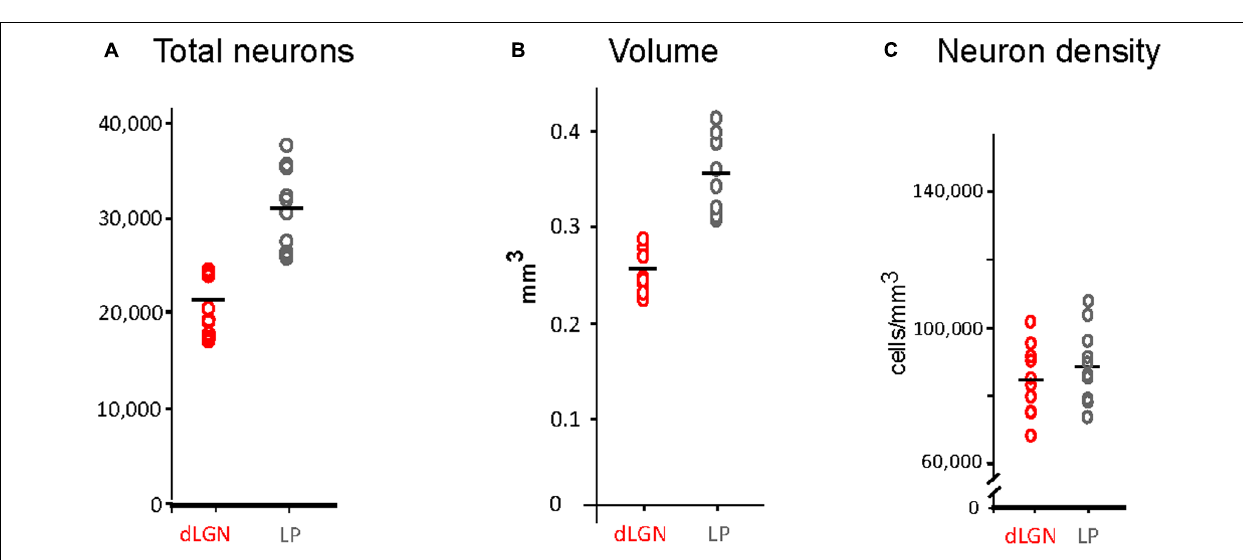
FIGURE 4 | Stereological estimations of volume, total neuron number and density of dLGN and LP. (A) Total number estimations. Data points correspond to measurements in 10 cerebral hemispheres (five animals). Mean values are represented by a horizontal black line. (B) Volume estimation in mm 3 . Conventions as in (A) . (C) Estimations of neuronal density (cell/mm 3